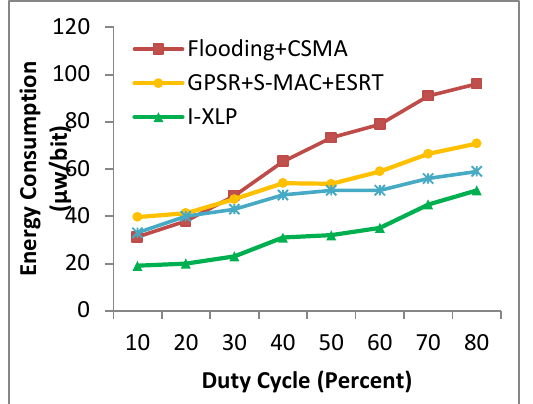
Fig. 12 Delivery ratio vs. duty cycle (for non prioritized traffic).